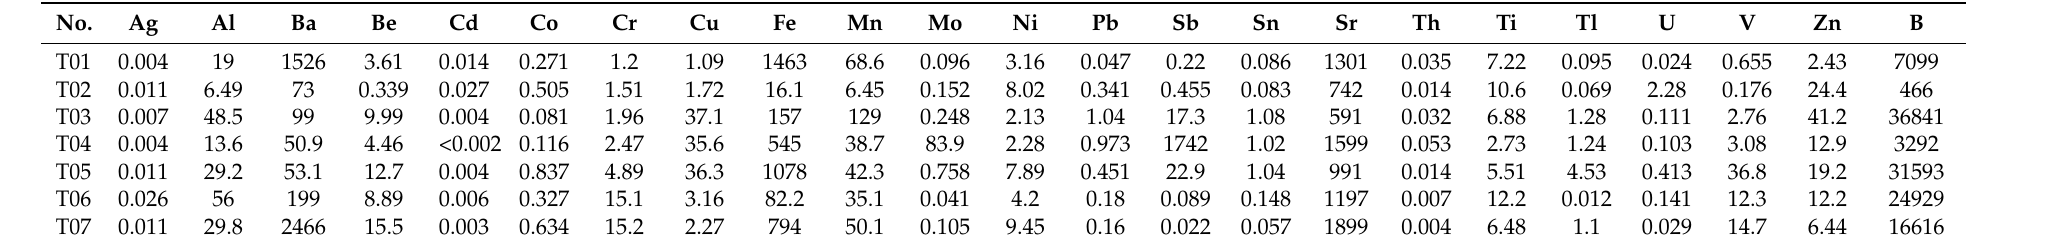
Table 3. The concentrations of trace elements in the spring waters along the TNR ( µ